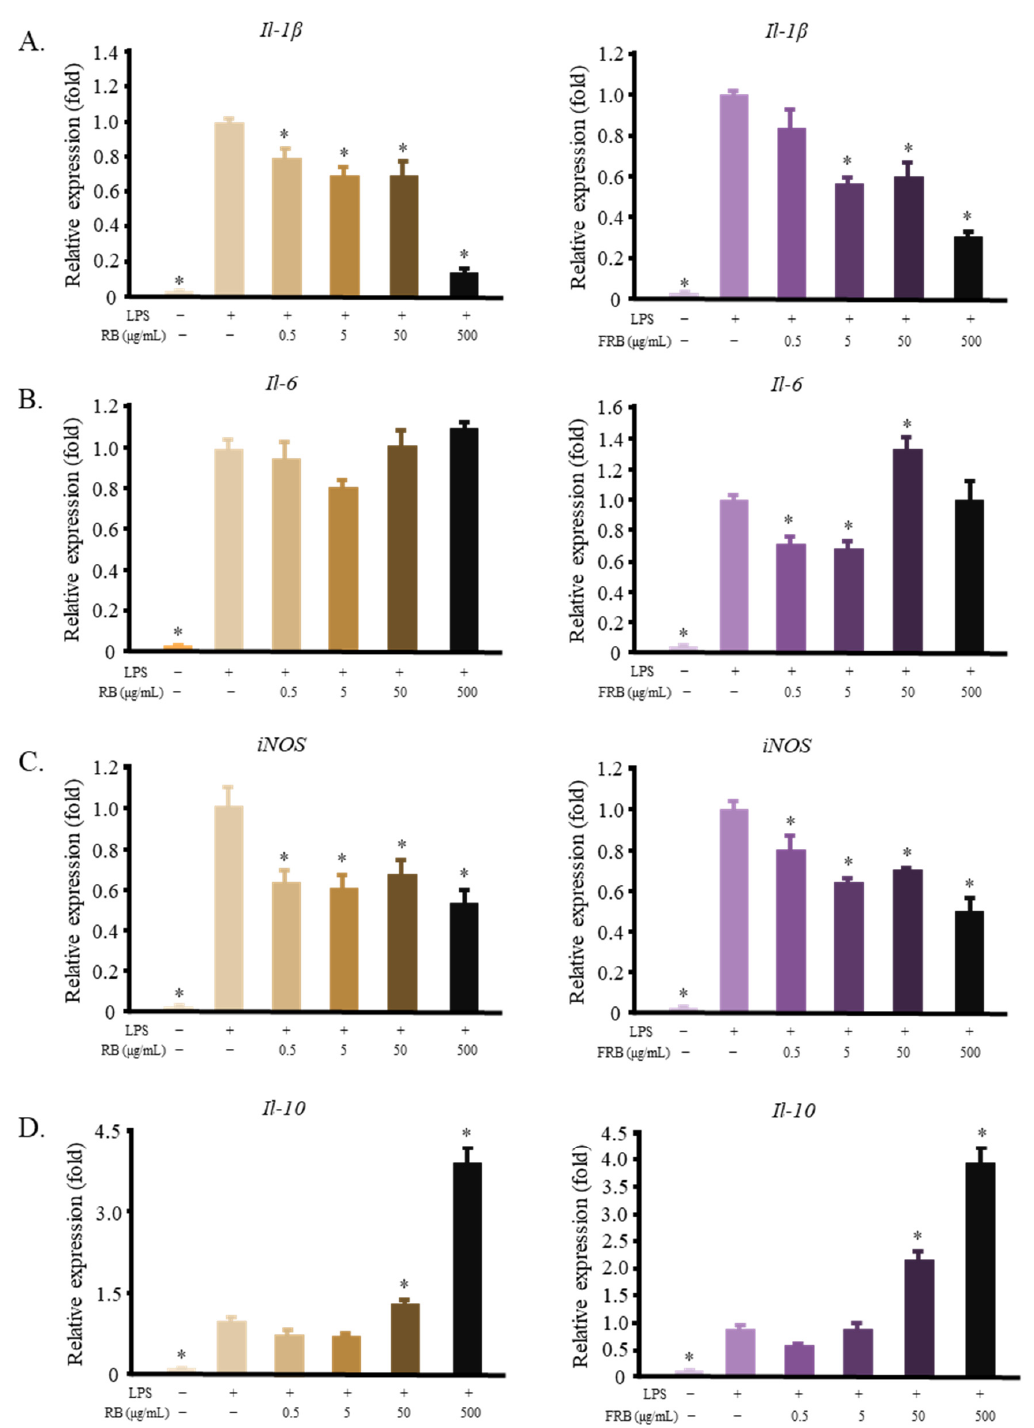
Figure 1. Both RB and FRB decrease the inflammatory reaction in LPS-stimulated RAW 264.7 cells. ( A ) RB and FRB lowered the mRNA level of Il-1 β ; ( B ) RB did not affect the expression of Il-6 , while FRB reduced the mRNA level of Il-6 ; ( C ) Both RB and FRB decreased the expression of iNos ; ( D ) RB and FRB increased the expression of Il-10 . The data are represented as mean ± SE, n = 3. Significant differences between the LPS group and the other groups (Dunnet’s analysis, p < 0.05) are marked with asterisks (*).